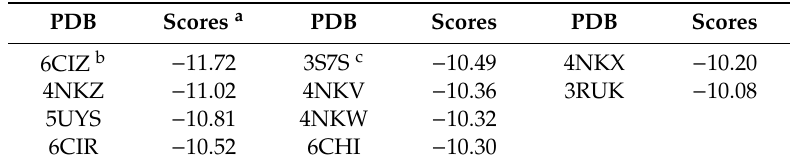
Table 6. Possible cancer-associated protein targets for compound 12n screened by fast docking against the protein data bank (PDB)